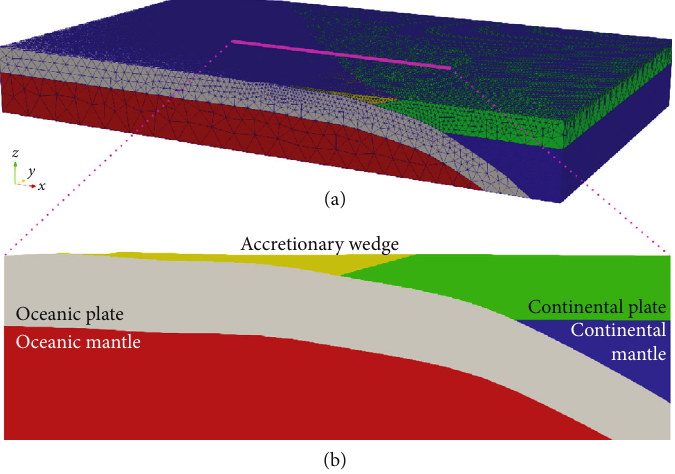
Figure 2: The fi nite element model used in our study. (a) The geometry mesh size ranged from 2.5km near the source up to 100km. The model size was 1500 km × 1700km × 200km . (b) The material model used in this study. The yellow block indicates the accretionary wedge, the gray block is the oceanic plate, the red block is the oceanic mantle, the green block is the continental plate, and the blue block is the continental